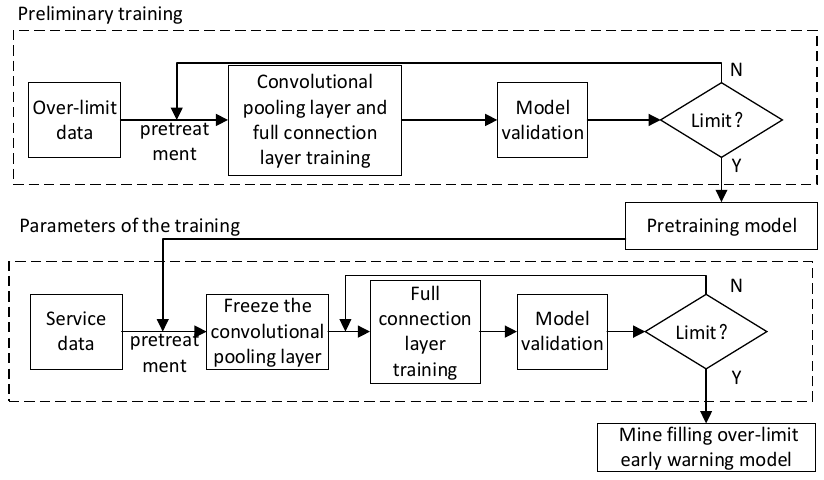
Figure 2. Flow chart of the overlimit prediction method.